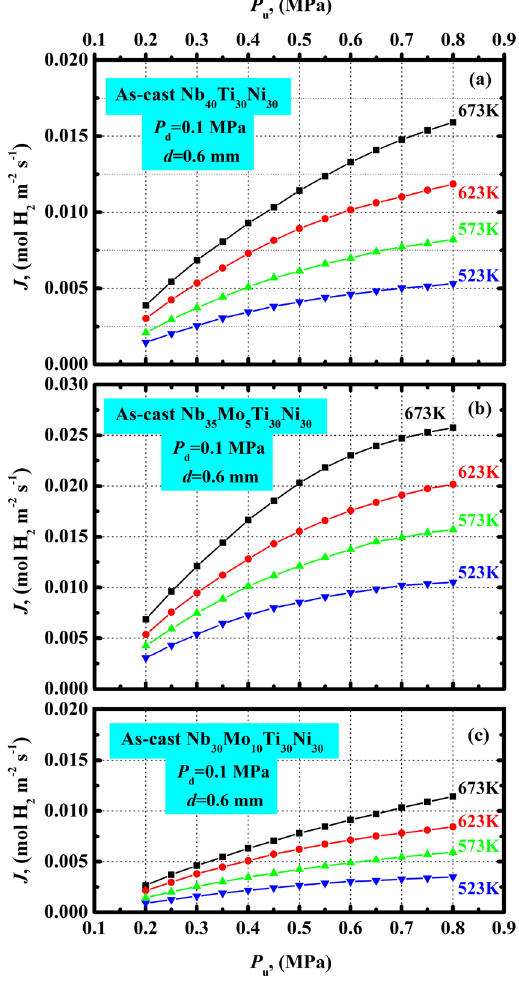
Figure 5. Steady-state hydrogen flux ( J ) plotted against the upstream hydrogen pressure ( P u ) for the as-cast